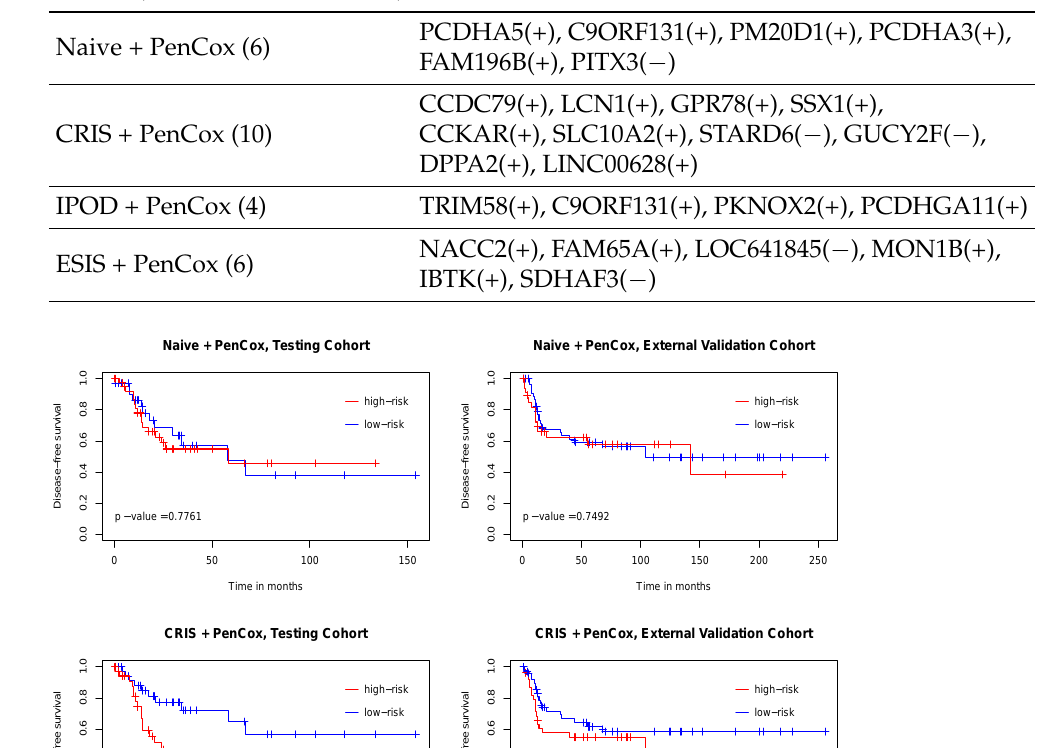
Table 2. Genes selected by the four competing models. A risk gene with a positive coefficient from the fitted PenCox model is denoted by “+”, while a protective gene with a negative coefficient is denoted by “ − ”.